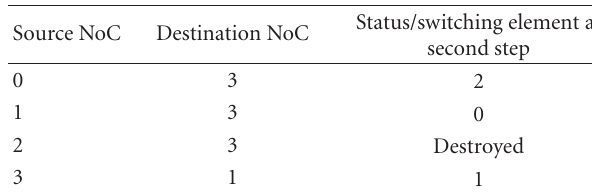
Table 3: Intermediate SE information while data moves from source NoC to destination NoC at second step of best case.